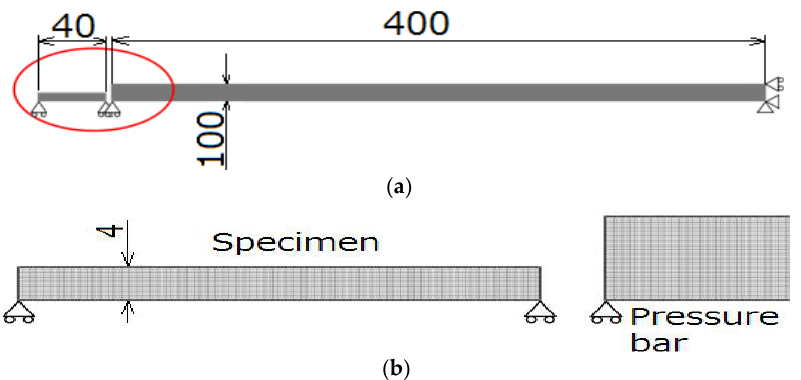
Figure 4. The finite element model of the modified Taylor impact test using a pressure bar. ( a ) The whole view and ( b ) the magnified view around an interface between the specimen and the pressure bar, as shown in the red circle of the figure ( a ) (dimensions in mm).